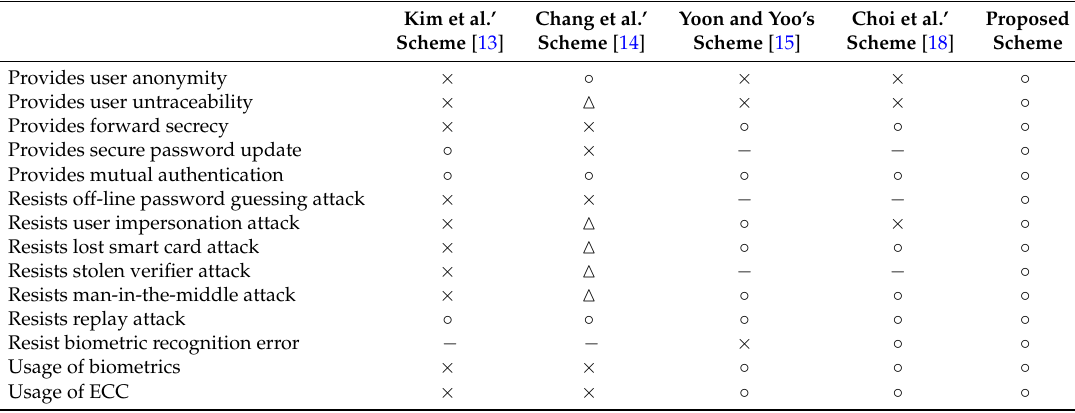
Table 3. Comparisons of the functionality features. ECC, elliptic curve cryptosystem.